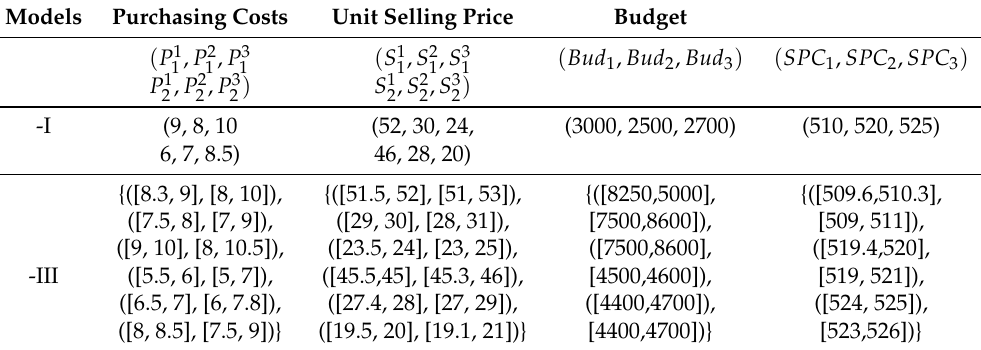
Table 4. Parametric values for the Models.